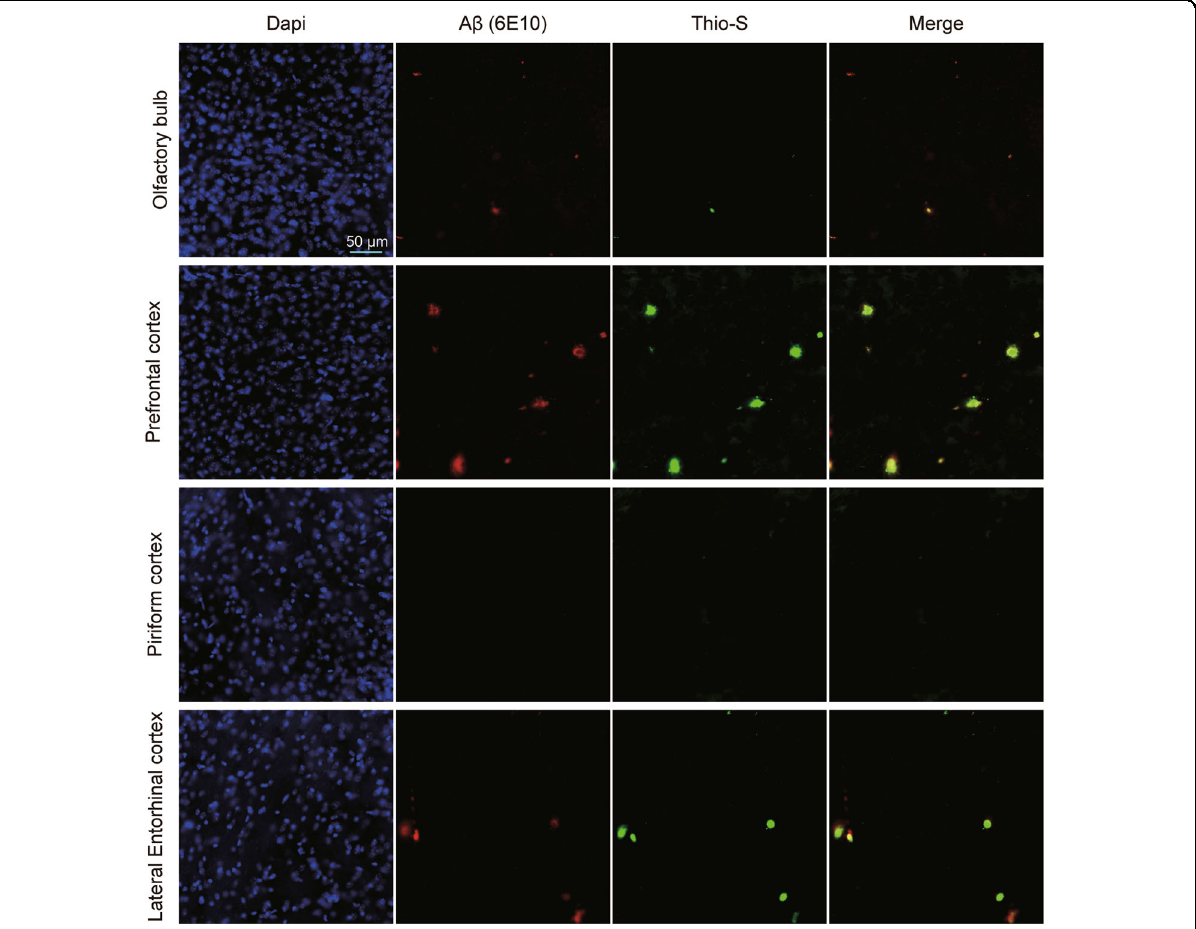
Fig. 5 Assessing the amyloid-beta (A β ) deposits in the olfactory bulb, medial prefrontal cortex, piriform cortex and entorhinal cortex of 5 × FAD mice. A Representative images showing A β staining in the olfactory bulb, medial prefrontal cortex, piriform cortex and entorhinal cortex in different experimental conditions. Scale bars represent 50 μ